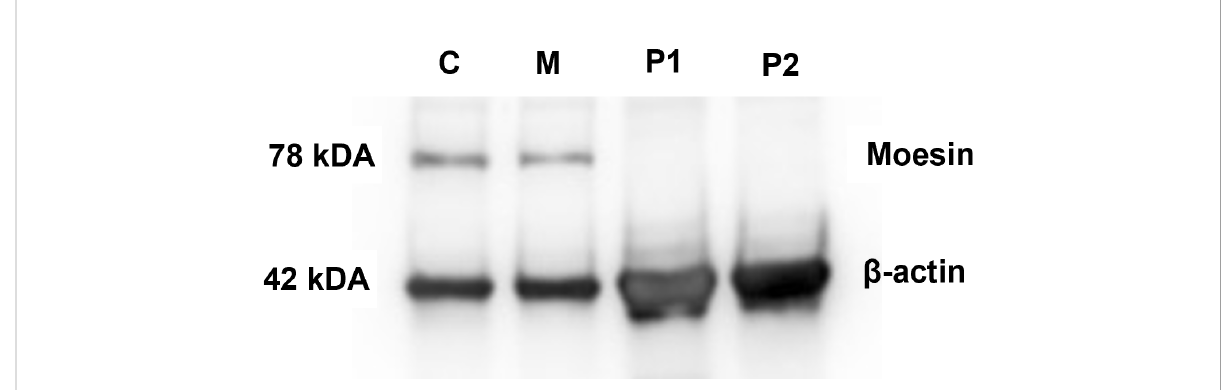
FIGURE 5 MSN protein detection. Western blot analysis showing the presence of moesin in PMBCs of healthy controls (C) and the patients ’ mothers (M). Beta-actin was used as the loading